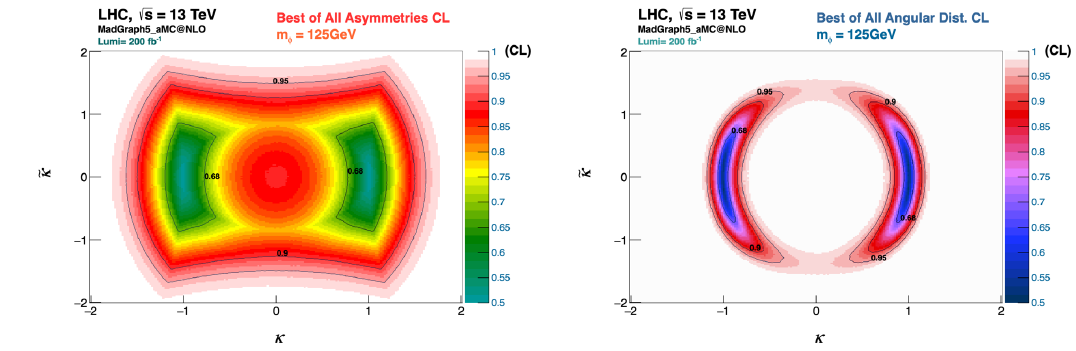
Figure 7 . The best exclusion limits, from all single asymmetry exclusions, are shown (left), as well as the best exclusion limits from the angular differential distributions (right), for a luminosity corresponding to the full RUN 2 data and first year of RUN 3 i.e., L =200 fb − 1